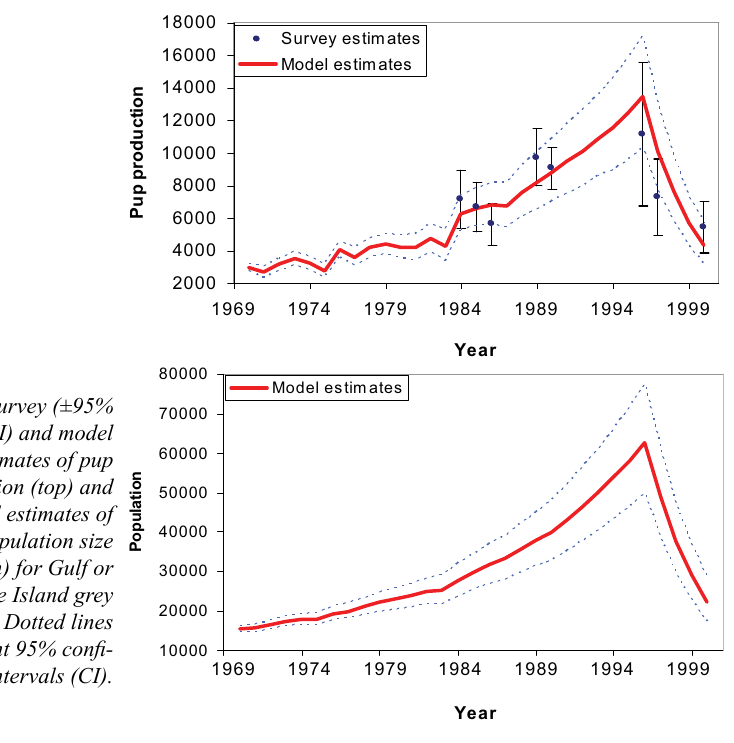
(bottom) for Gulf or non-Sable Island grey seals. Dotted lines represent 95% confi - dence intervals